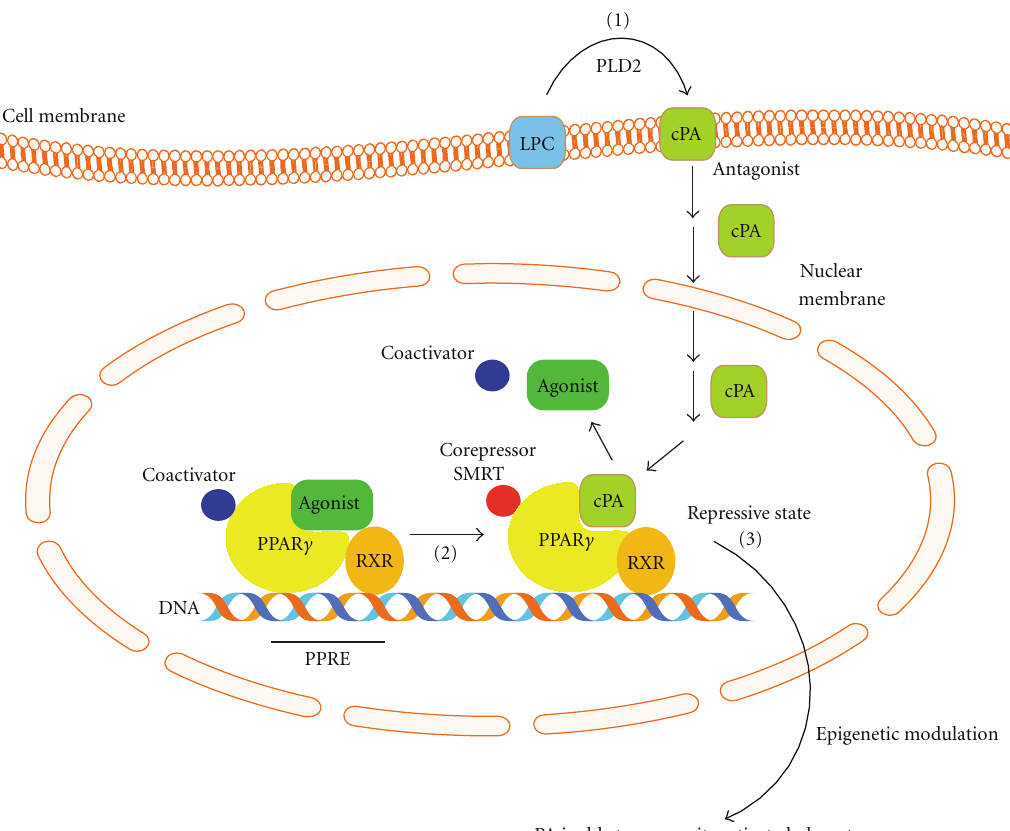
Figure 2: Schematic diagram of the PPAR γ signaling. cPA is generated intracellularly in a stimulus-coupled manner by the PLD2 enzyme (1). cPA inhibits PPAR γ activation and stabilizes binding of PPAR γ corepressor SMRT (2). Agonists (LPA, alkyl-LPA, and rosiglitazone) activate PPAR γ and promote downstream signals, whereas cPA negatively regulates PPAR γ . cPA stabilizes PPAR γ -SMRT corepressor complex and inhibits PPAR γ -mediated postsignal transduction